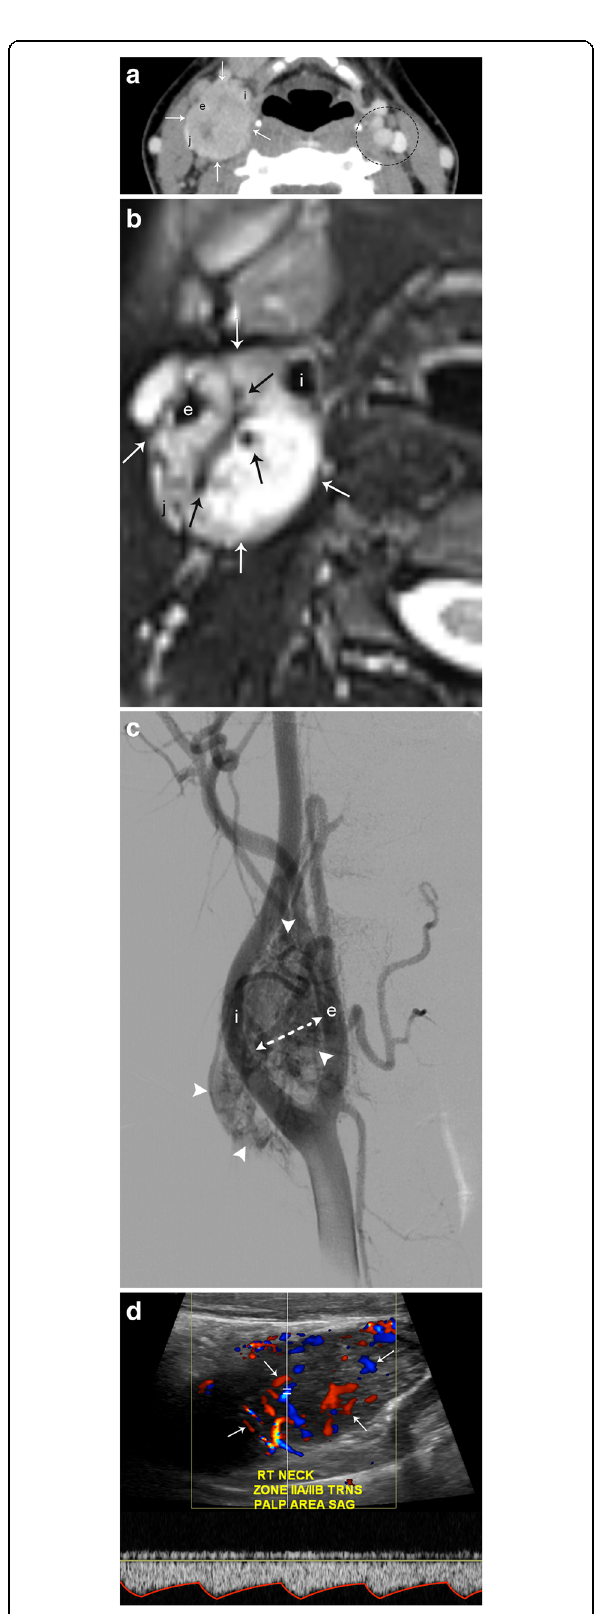
Fig. 2 Carotid body tumor. a Axial CT image demonstrates a well-circumscribed, enhancing mass centered in the right carotid space (arrows) that causes splaying of the right internal (i) and external (e) carotid arteries. There is mass effect on the internal jugular vein (j). The left carotid space (dotted circle) demonstrates the normal relationship of the carotid and jugular vessels. b Axial T2-weighted MR image shows a well-circumscribed hyperintense mass (white arrows) with multiple internal flow voids (black arrows). c DSA demonstrates an intensely hypervascular mass (arrowheads) centered at the carotid bifurcation. Again seen is splaying of the internal and external carotid arteries. d Spectral Doppler ultrasound confirms hypervascularity (arrows) and internal arterial flow (spectral tracing) of this